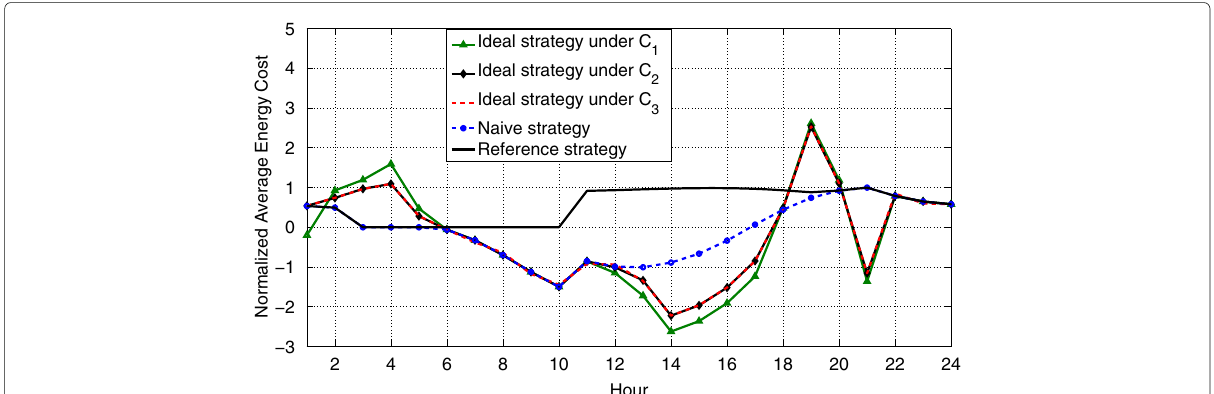
Fig. 12 Normalized daily energy cost of the ideal (under C 1 , C 2 , and C 3 ), the naive , and the reference strategies, averaged over 5 years